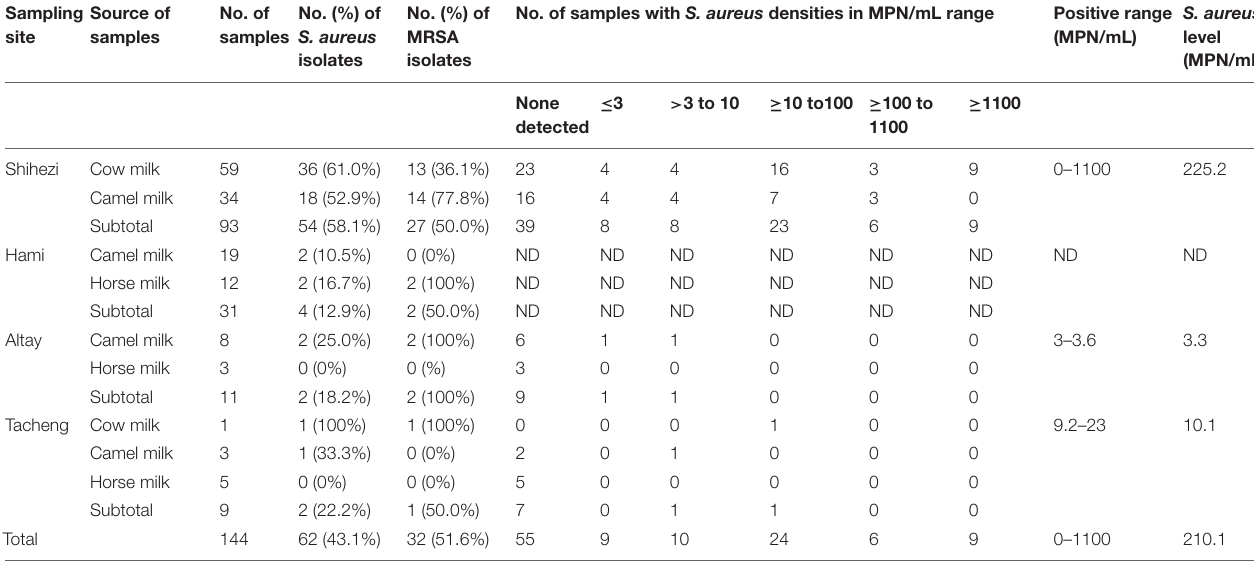
TABLE 2 | Prevalence and levels of S. aureus at the different sampling sites. Sampling Source of site samples